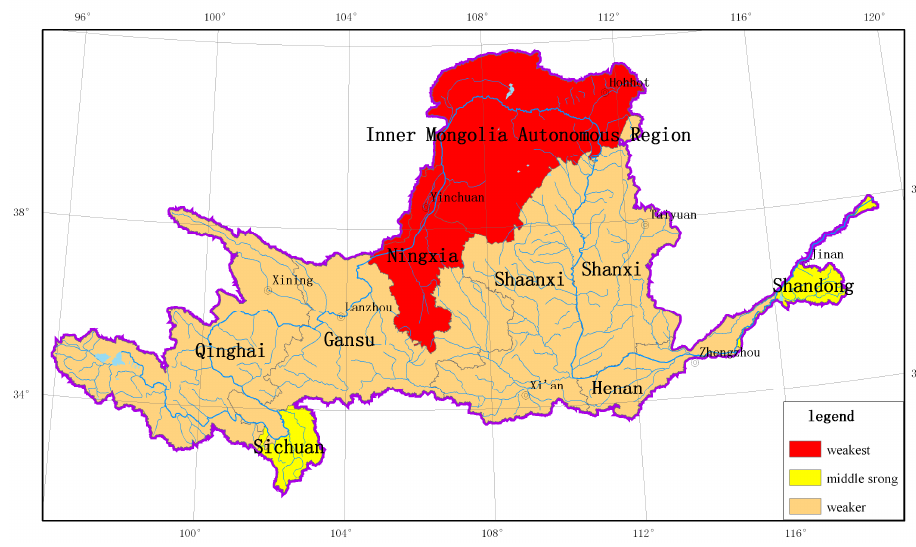
Fig.2 The result of water resource renewability assessment in the Yellow River Basin Fig. 2. The result of water resource renewability assessment in the Yellow River